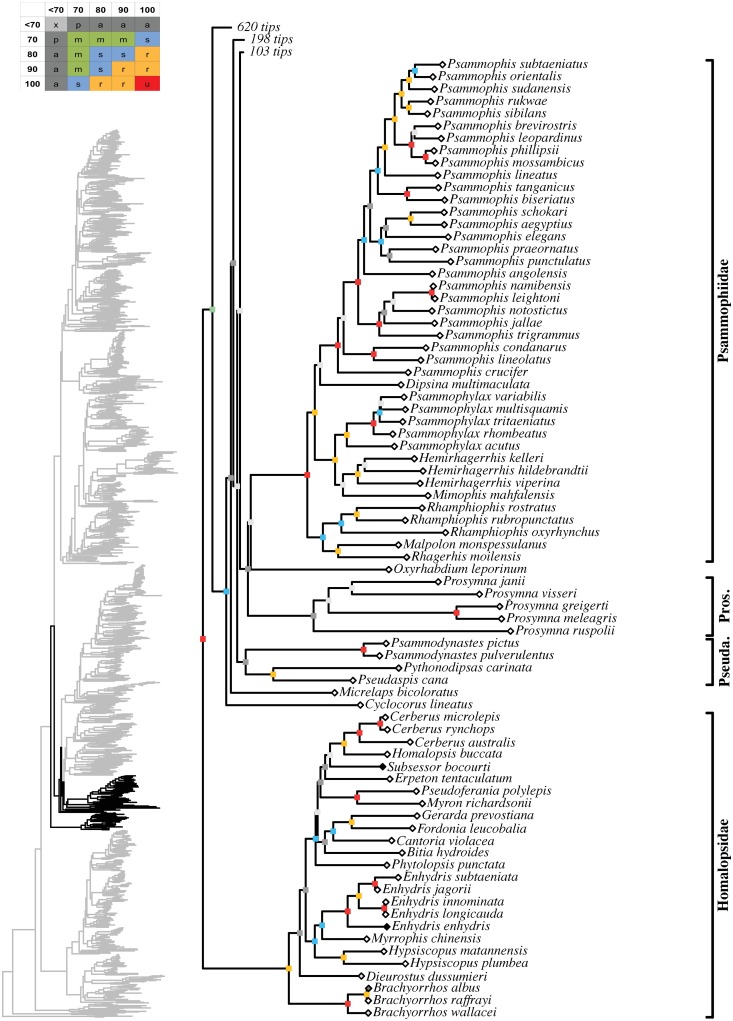
Maximum likelihood species-level phylogeny of Colubroides
(continued).Basal Elapoidea, families Homalopsidae, Cyclocoridae, Pseudaspididae,
Psammophiidae.